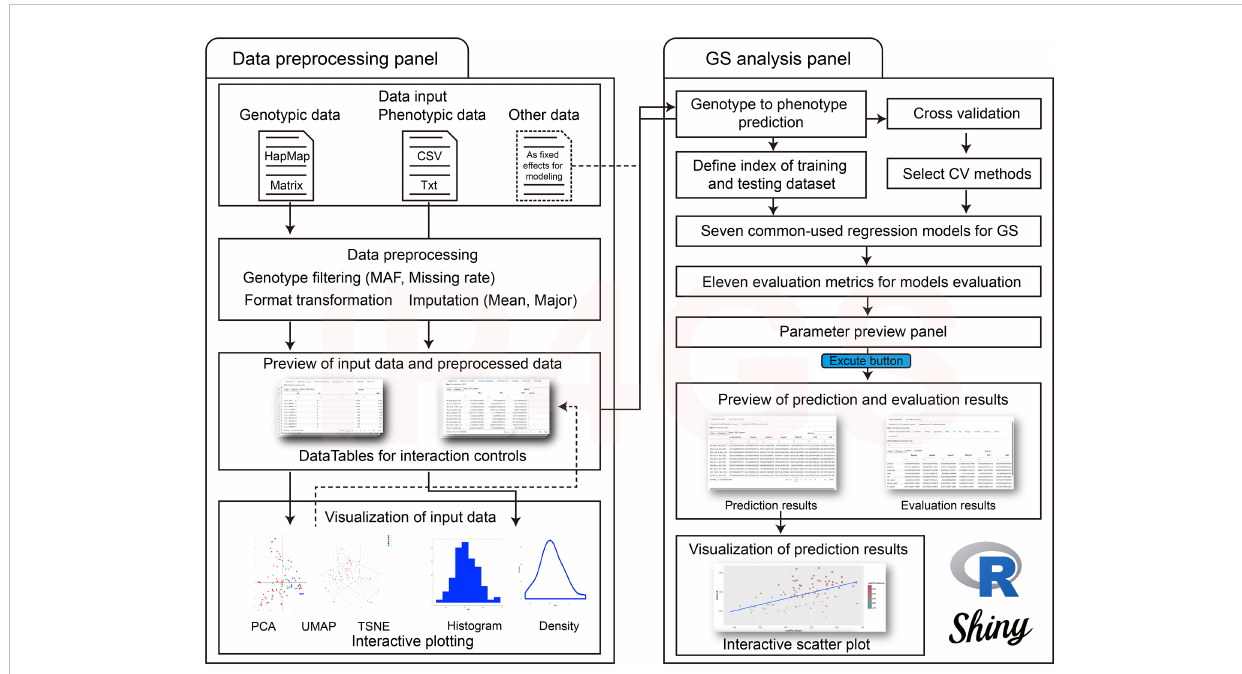
FIGURE 1 Overall work fl ow of IP4GS. IP4GS comprises two panels of functional modules: the Data preprocessing panel (left) and the GS analysis panel (right).